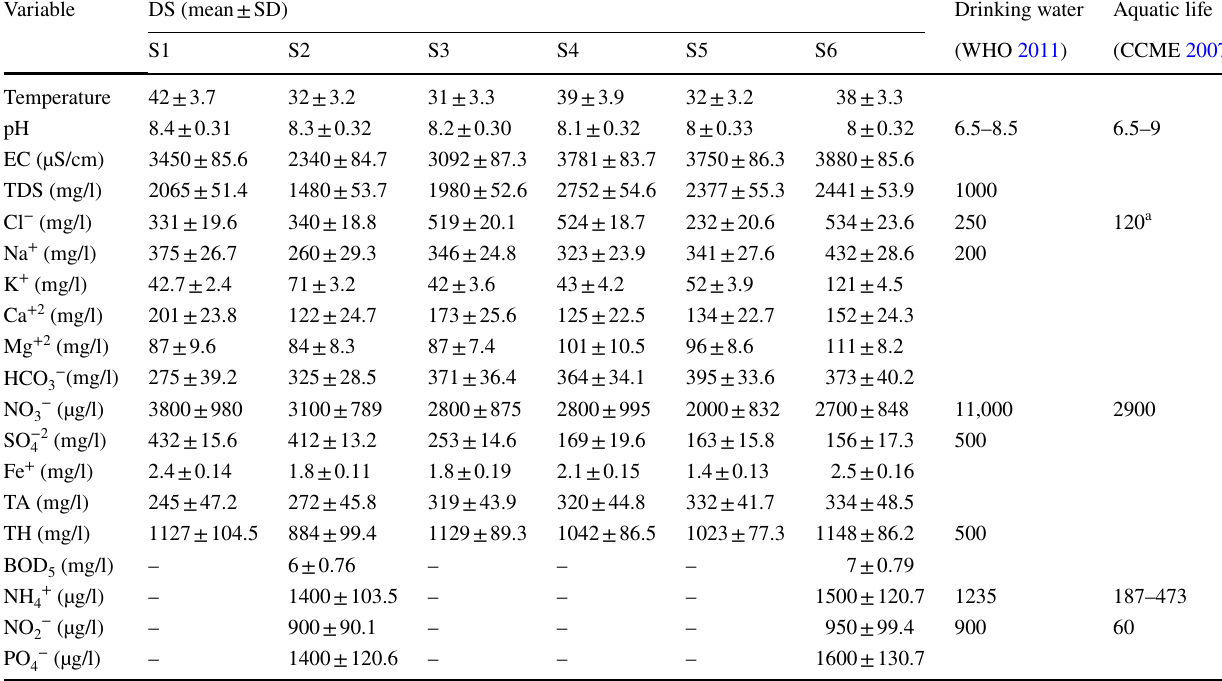
Table 1 Water quality parameters values of Shatt Al-Arab River and comparative guidelines during the dry season (DS)